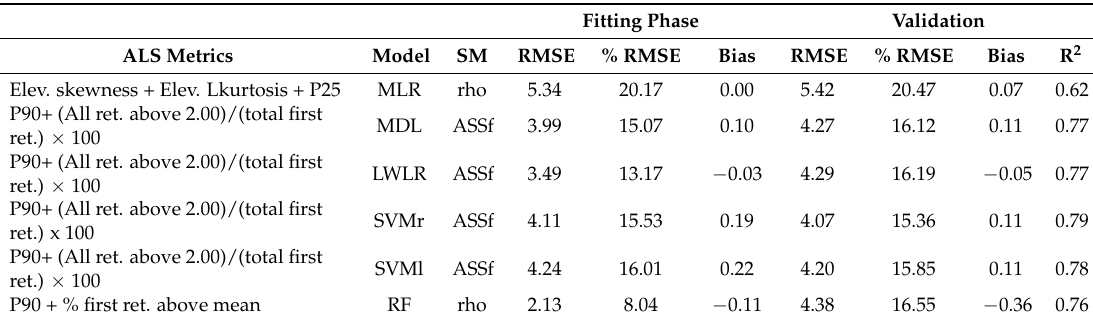
Table A8. Summary of the Do models using 2011 ALS data. Validation results in terms of RMSE (cm), %RMSE, and bias (cm) and R 2 . SM refers to selection method; Step. stands for Stepwise both and forward; SVMr. refers to Support Vector Machine with radial kernel; SVM l. refers to Support Vector Machine with linear kernel; ret. refers to returns.